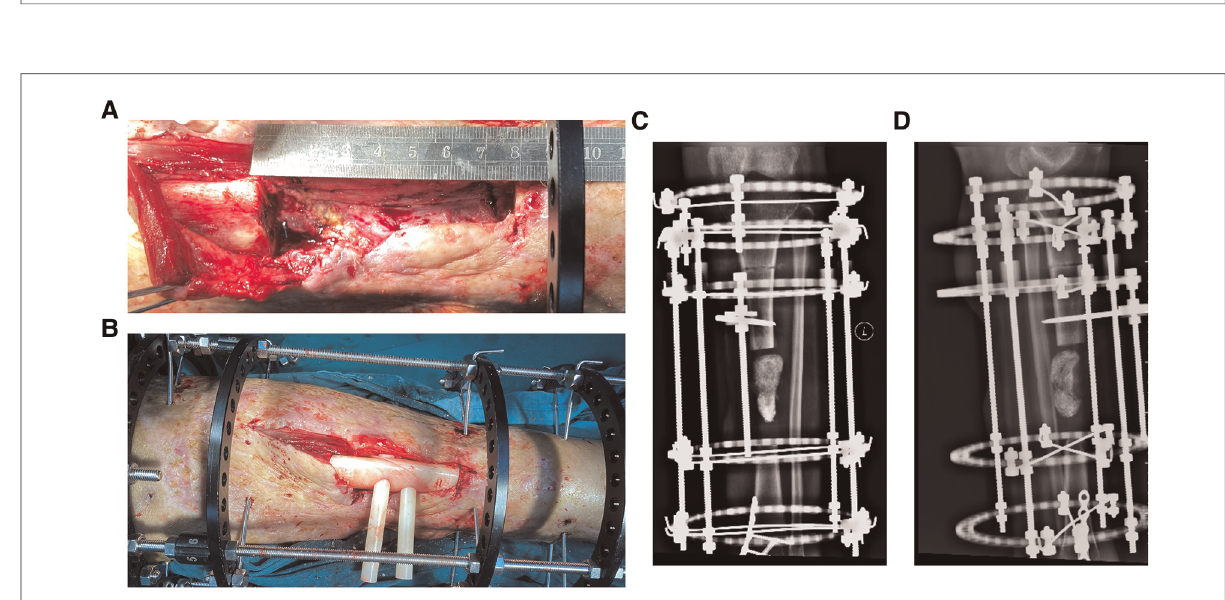
FIGURE 7 The osteotomy was carried and intraoperative application of PSI in Ilizarov technique of distraction osteogenesis and the postoperative x-ray image in case 2. ( A ) Intraoperative image of case 2 after osteotomy. ( B ) The PSI was put into the bone defect to assist reduction. ( C ) x-ray image on Anterior-posterior (AP) view after operation of case 2, and the iodoform gauze were fi lled in bone defect. ( D ) x-ray image on lateral view after operation of case